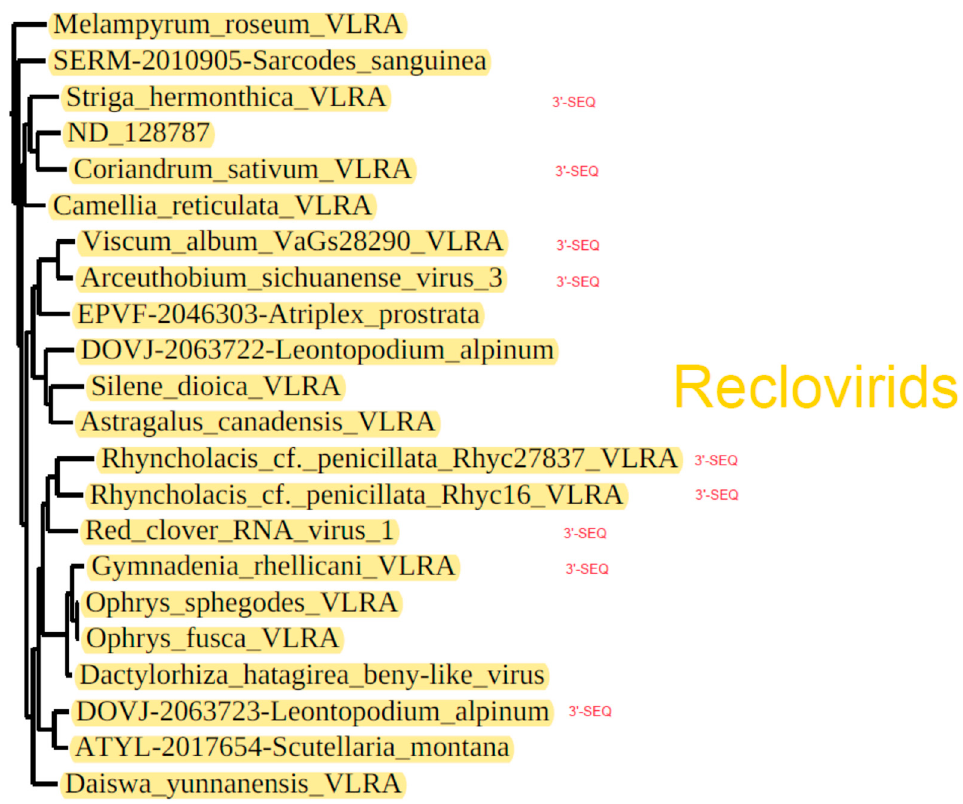
Figure 8. Phylogenetic subtree of the whole tree of RdRp domains from Figure 2 showing Reclovirid cluster of Viridiplantae-specific viruses. Viruses with conserved genomic 3’-termini are marked by 3’-SEQ (see text for details).